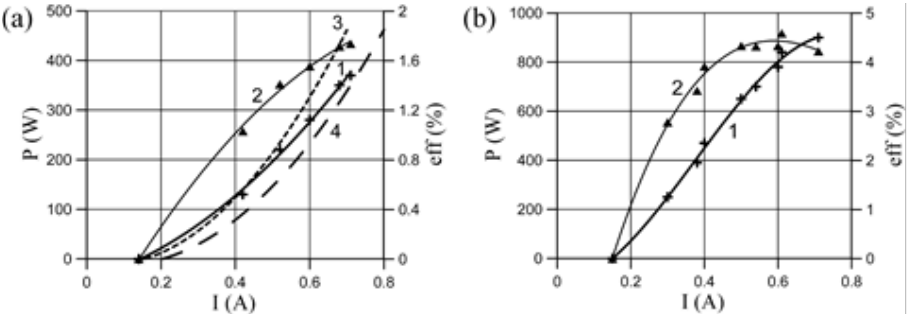
Fig. 2. The measured output power (marked + on line 1) and efficiency (triangles on line 2), as well as the calculated output power at a pitch factor of 1.5 (line 3) and 1.4 (line 4) for LOG in the case of second (a) harmonic and third (b) harmonic